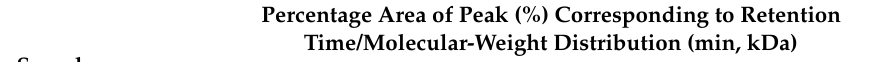
Table 1. Effect of HHP pretreatment on the molecular-weight distribution of RBPH.